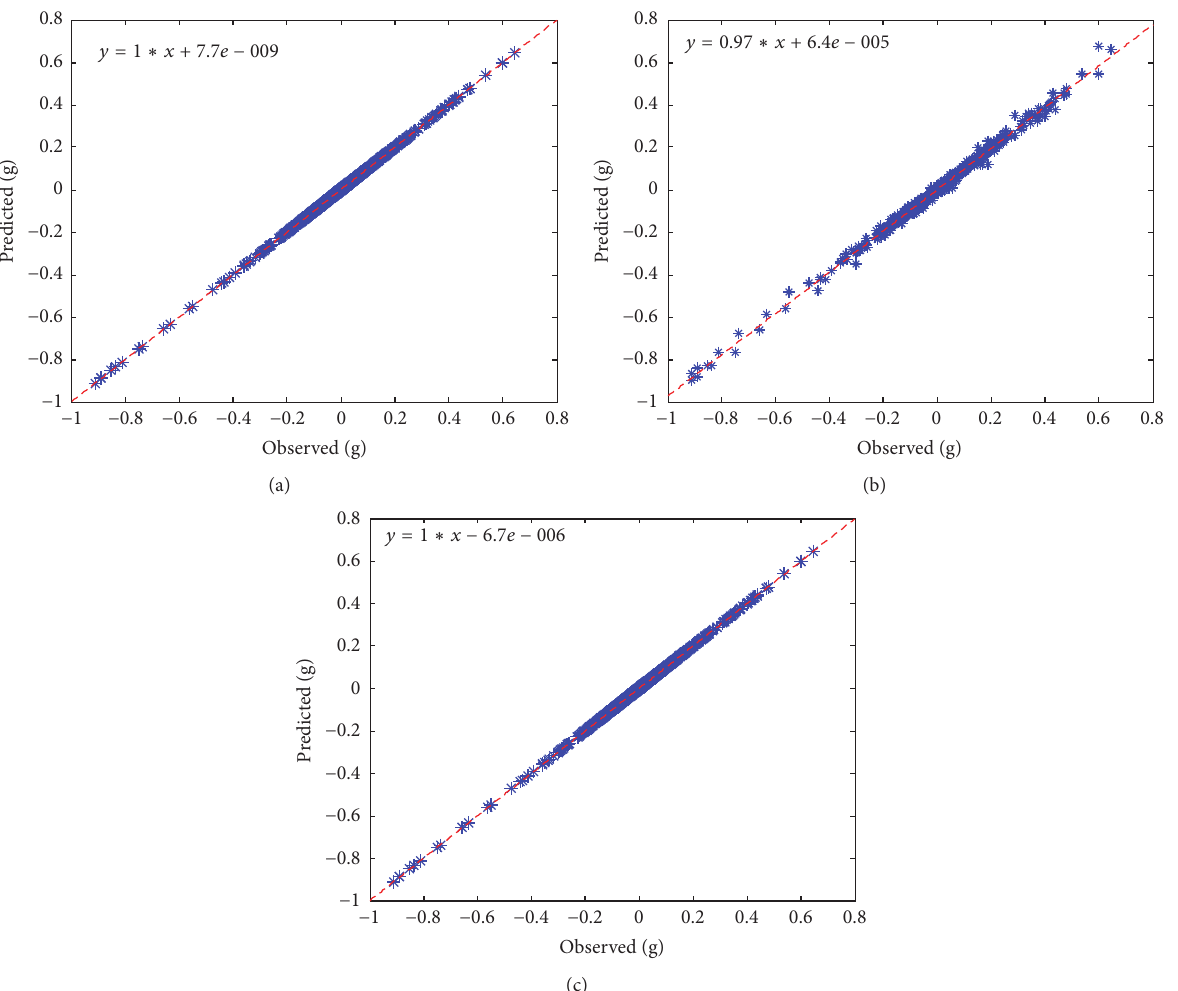
Figure 7: Prediction response of three models with measured GM, (a) LSSVM, (b) WNN, and (c) ANFIS.